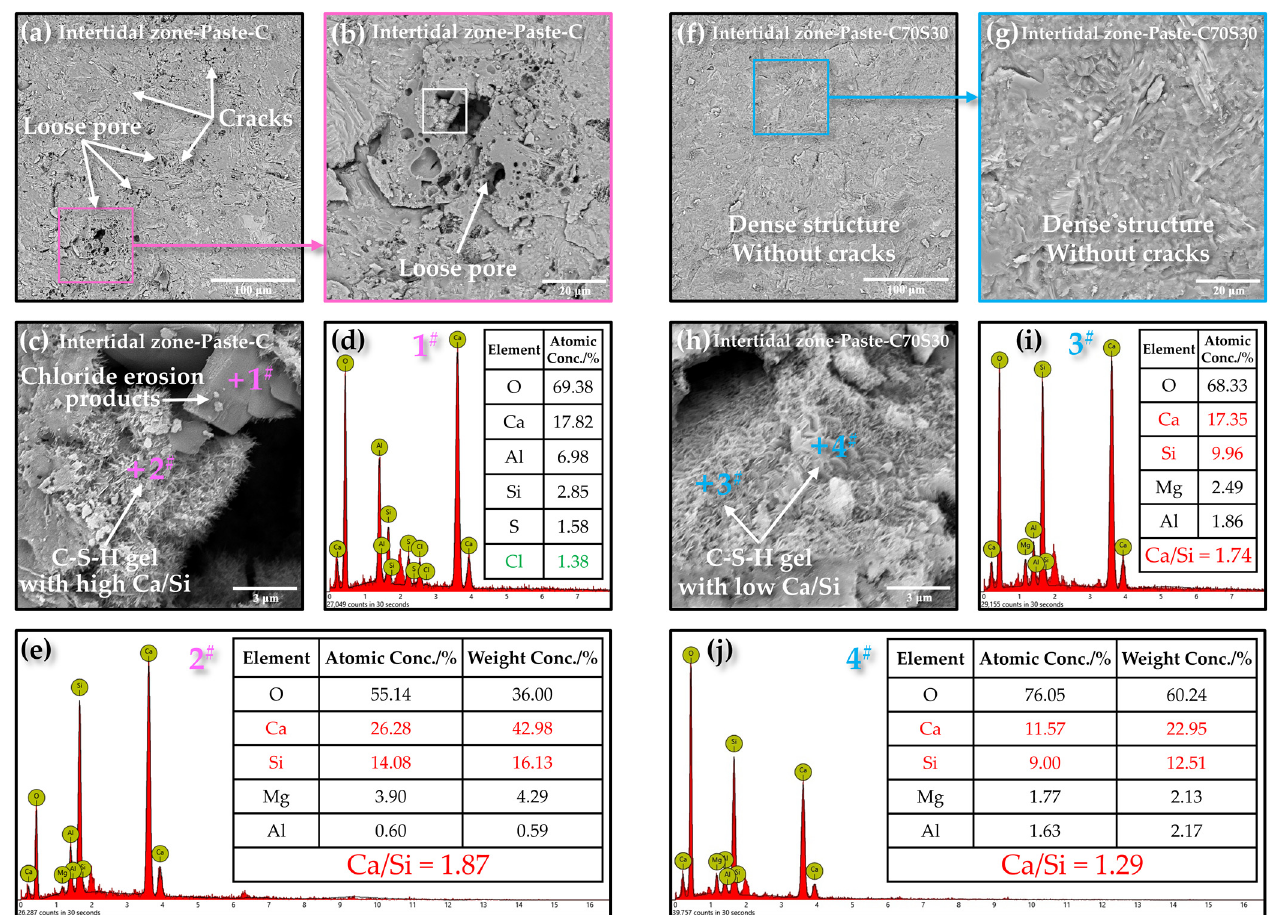
Figure 12. The influence of slag powder on the internal microstructure of CBRM-Paste after 180 days of dry–wet cycles-coupled chloride ion erosion. The SEM photos of Intertidal zone-Paste-C at ( a ) 800 magnification, ( b ) 3000 magnification, and ( c ) 20,000 magnification. The EDS results of spot 1 # ( d ) and 2 # ( e ). The SEM photos of Intertidal zone-Paste-C70S30 at ( f ) 800 magnification, ( g ) 3,000 magnification, and ( h ) 20,000 magnification. The EDS results of spot 3 # ( i ) and 4 # ( j ).